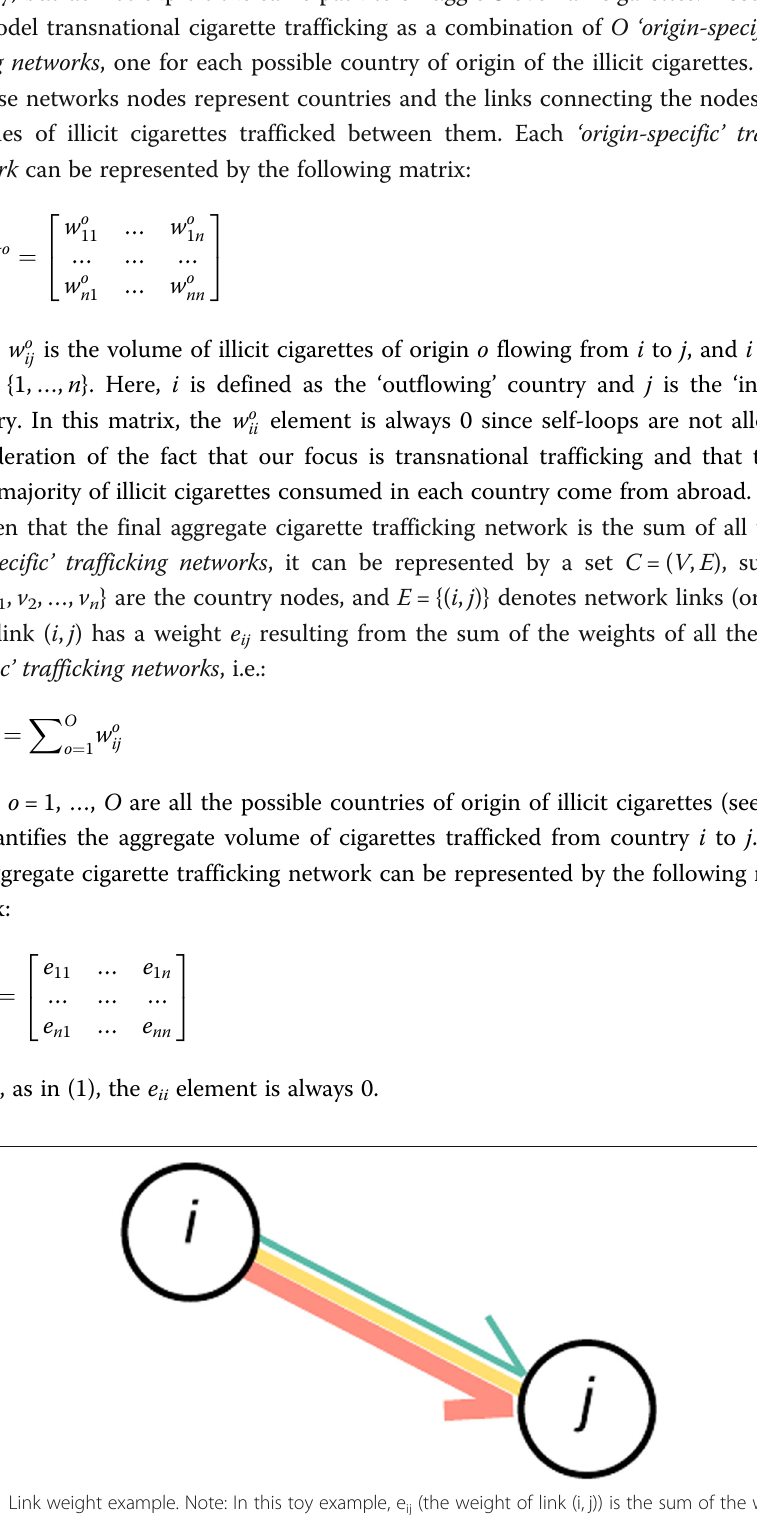
(in pink), w o 0 (in yellow), and w o 0 0 (in ij ij ij